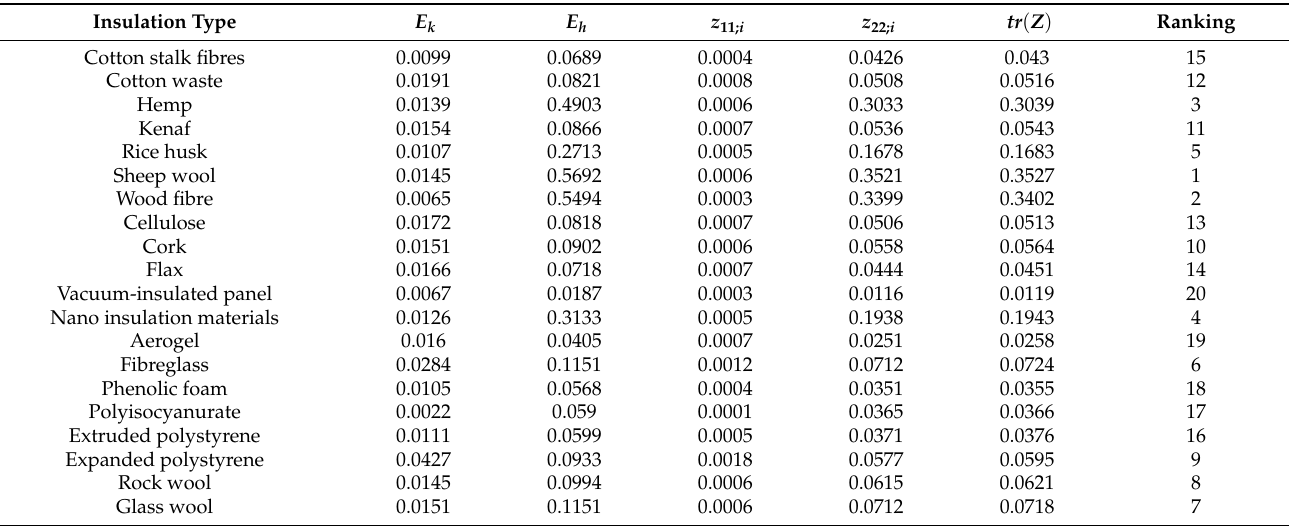
Table 12. Table 12. The results of the MCRAT